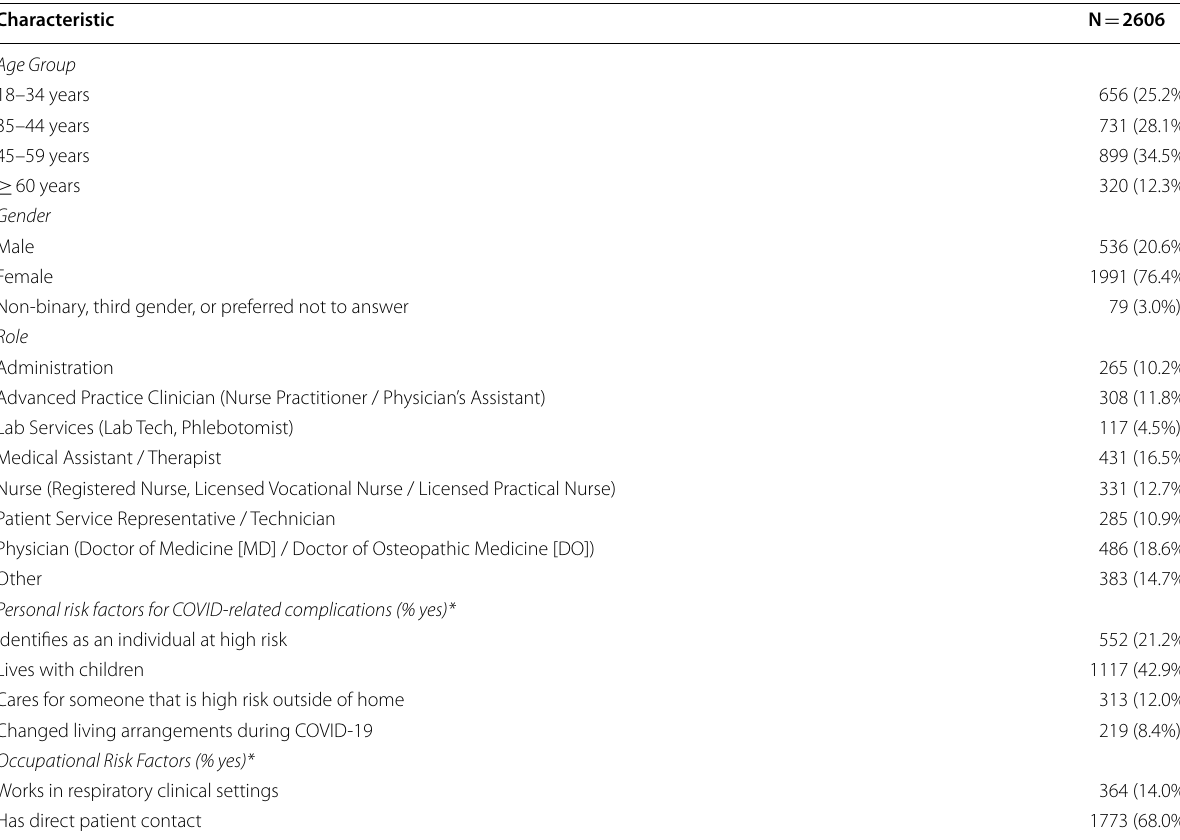
Table 1 Characteristics of study